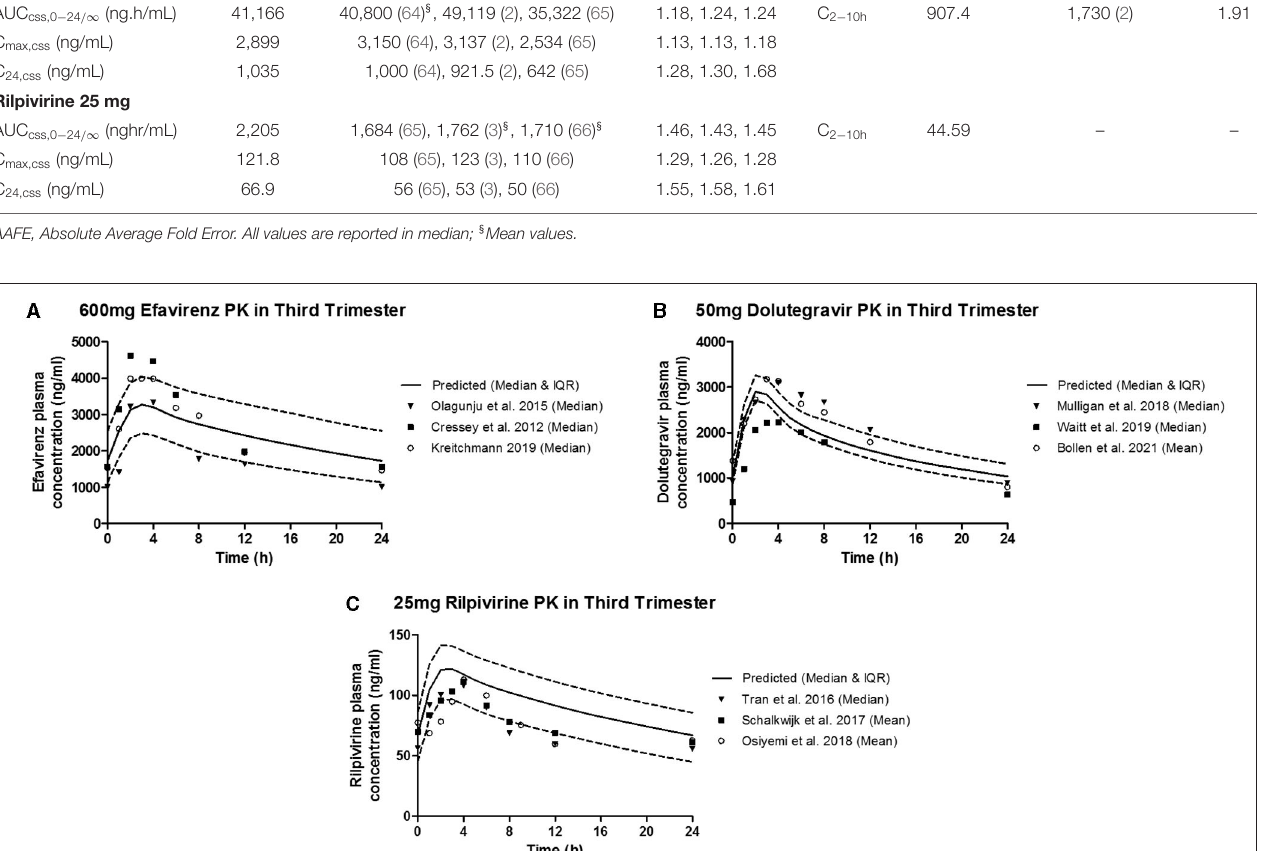
similar to predictions in the m-f-PBPK model without lymphatic component ( data not shown